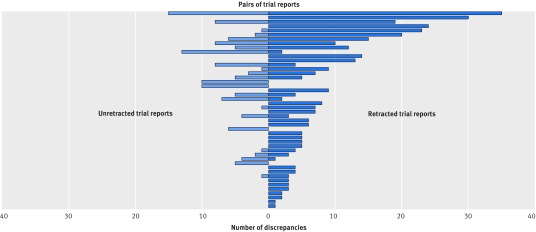
Fig 1 Discrepancy counts. Paired comparison between retracted reports (right) and unretracted control counterparts (left) for all 100 reports studied. Each bar represents the number of discrepancies in one trial. Pairs are ordered by total number of discrepancies in the pair, with those with the most discrepancies at the bottom